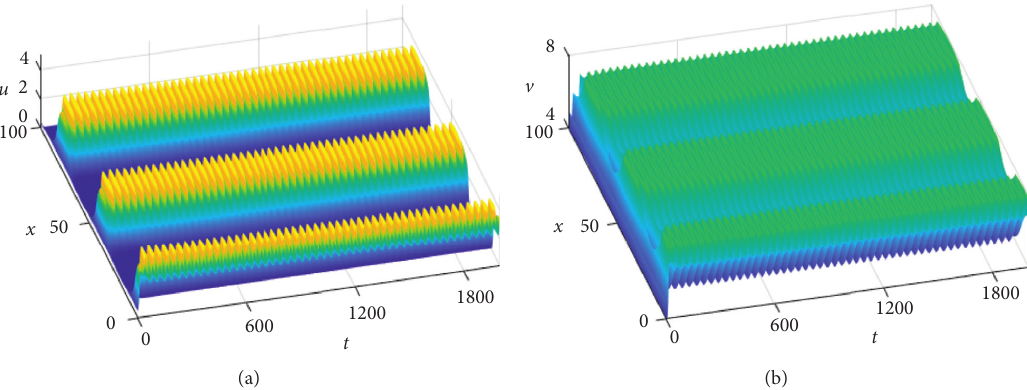
Figure 9: Numerical solutions of system (6a)–(6c): (a) prey population u and (b) predator population v , where r ( t, x ) � 0 . 9 + 0 . 001 sin ( 5 ∗ π ∗ t /100 ) + 0 . 1cos ( t ∗ π ∗ x /100 ) and other parameters are the same as the ones in Figure